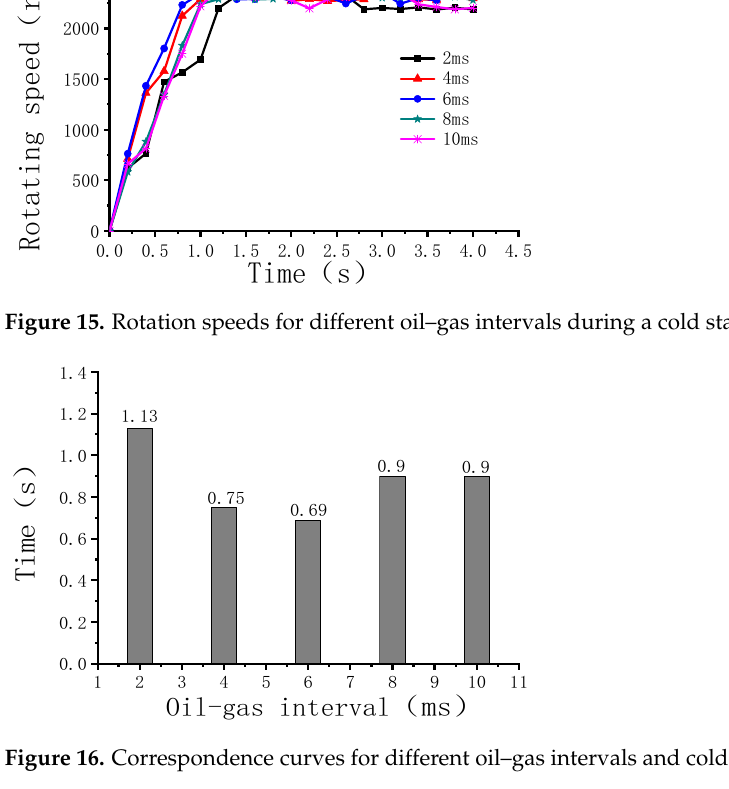
Figure 16. Correspondence curves for different oil–gas intervals and cold-start times.